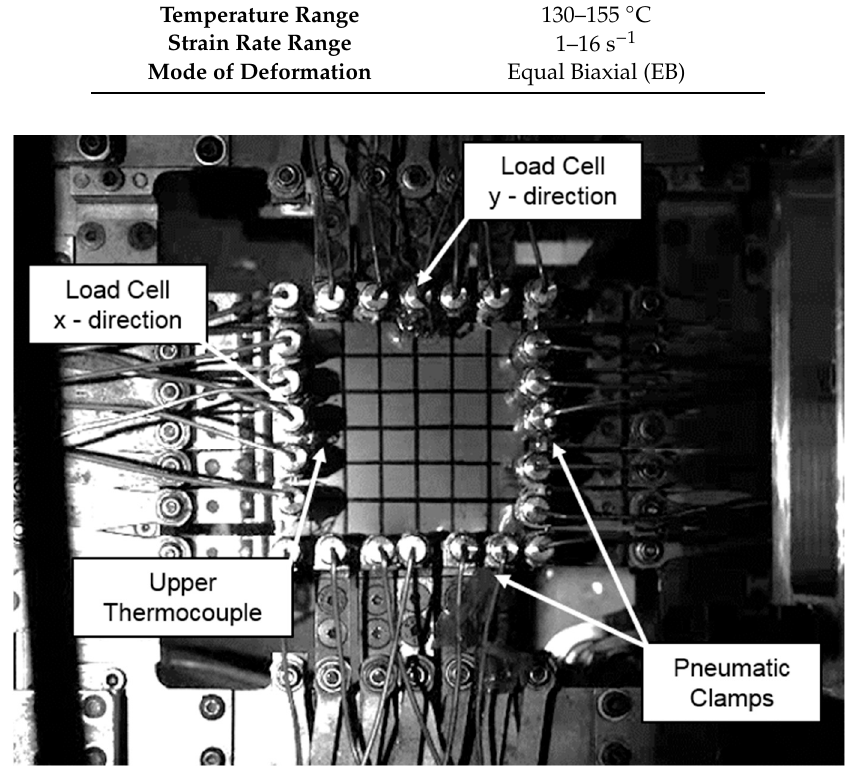
Figure 1. Annotated photo of poly-aryl-ether-ketones, poly(ether-ether-ketone) (PEEK) film mounted in Queen’s Biaxial Stretcher (QBS) [13].